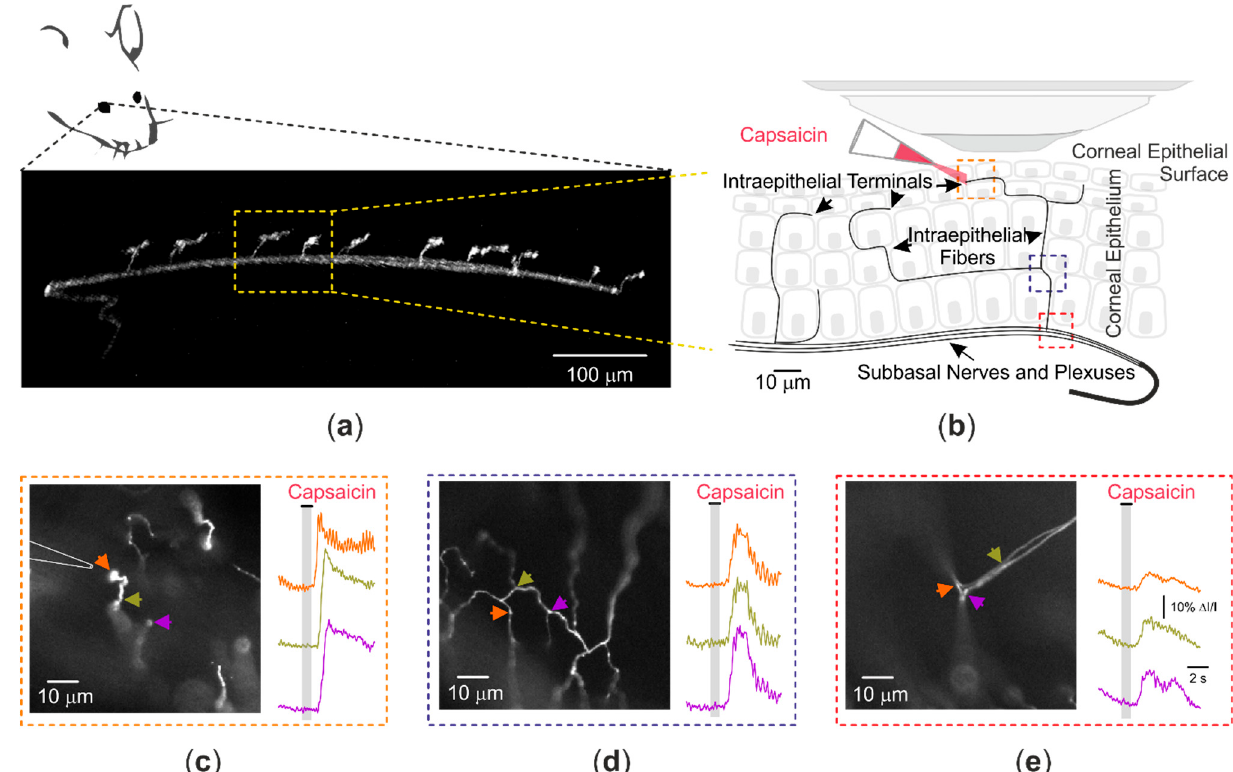
Figure 3. In vivo optical recording from nociceptive corneal nerve terminals and distal axons showing initiation and propagation of capsaicin-induced Ca 2+ signals. ( a ) Transversal fluorescence reconstruction of a sub-basal nerve, giving rise to several terminals within the corneal epithelium cells. ( b ) Scheme of the experimental preparation in which a non-invasive calibrated puff of capsaicin was used to stimulate corneal nociceptive nerve terminals. The capsaicin-evoked Ca 2+ transients were recorded along ( c ) the nociceptive terminal tips, ( d ) the terminal fibers, and ( e ) deeper into their parental plexuses. The corresponding areas in the transversal plane are shown in ( b ) (color-coded boxes). The traces (right panels) depict the changes in GCaMP6s fluorescence following application of capsaicin onto the terminal tip and they are color-coded according to the corresponding regions of interest (arrows shown in left panels). Reproduced from Goldstein et al., 2019 [26], with